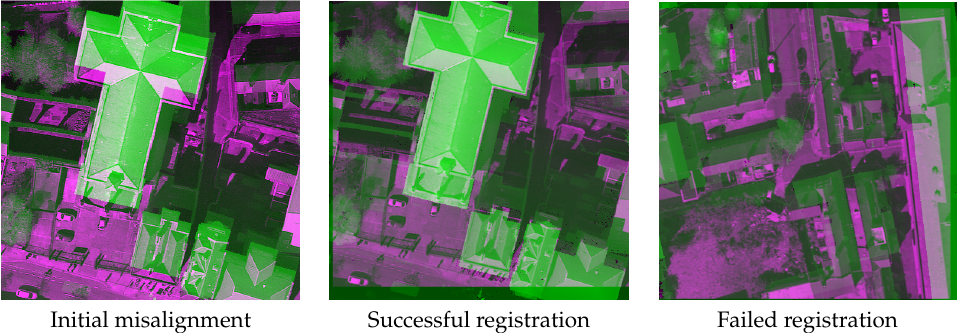
Figure 5. MI registration between return-pulse intensities (green) and optical image (purple) may fail when the scene content is significantly different between the two data